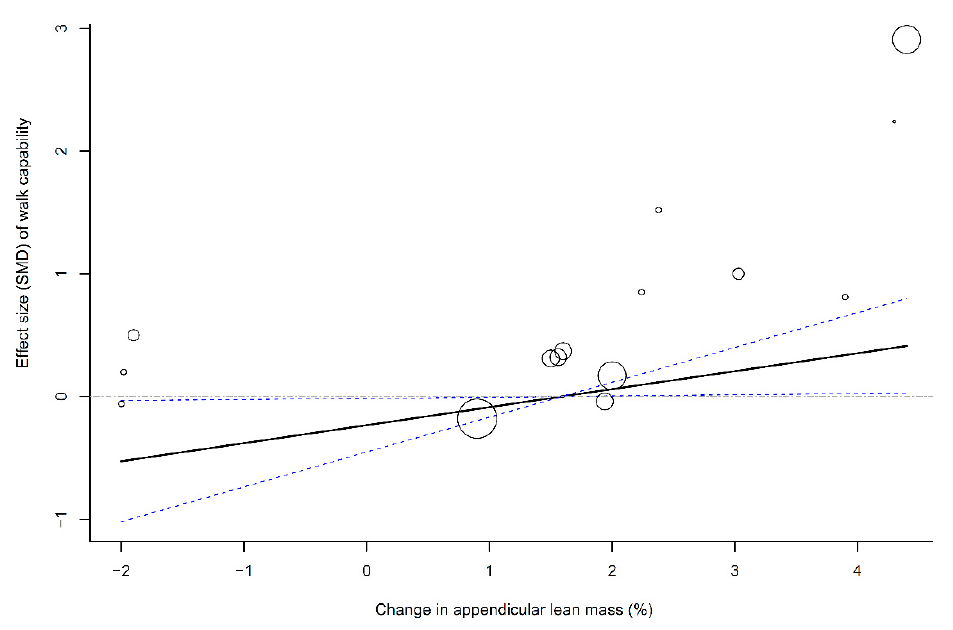
Figure 5. Multivariate meta-regression between percentage change in appendicular lean mass and effects of PS plus MSE on walk capability. Each circle represents an independent comparison. The size of each circle is proportional to that study’s weight (inverse variance weighted). The regression prediction is represented by the solid line for effect size (SMD) of walk capability. Dotted lines represent the 95% CI. The metaregression model was adjusted for age, methodological quality, and follow-up time of each comparison. PS, protein supplementation; MSE, muscle strengthening exercise; SMD, standard mean difference.